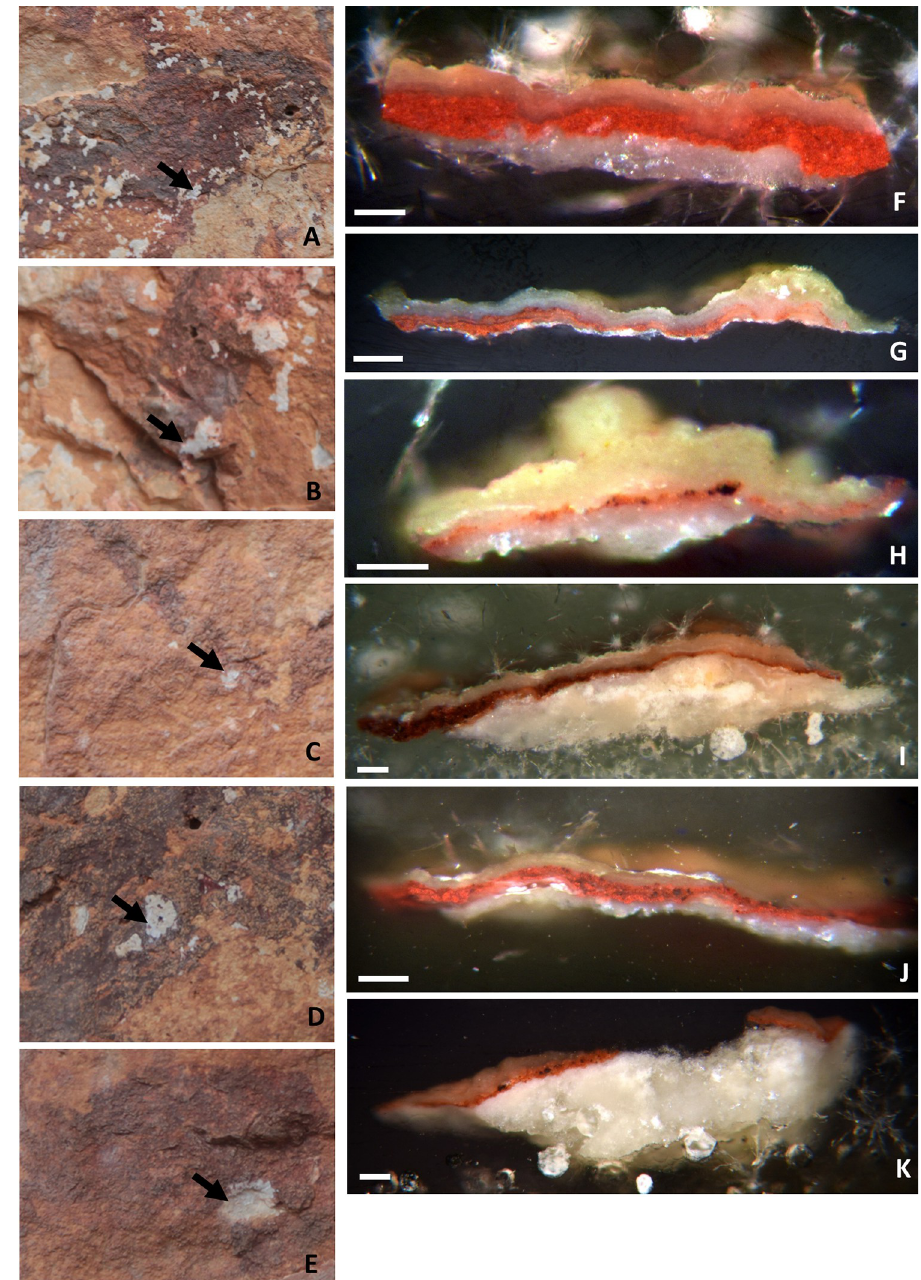
Fig 4. A-E: Location of the sampling areas before extraction. F-K: Optical microscope images of the cross-sections of the micro-samples collected in A-E. Images: A, F and G correspond to samples AC5.1 and AC5.2; B, H correspond to sample AC6; C, I correspond to sample AC7; D, J correspond to sample AC8; E, K correspond to sample AC9. Scalebar = 100 μ